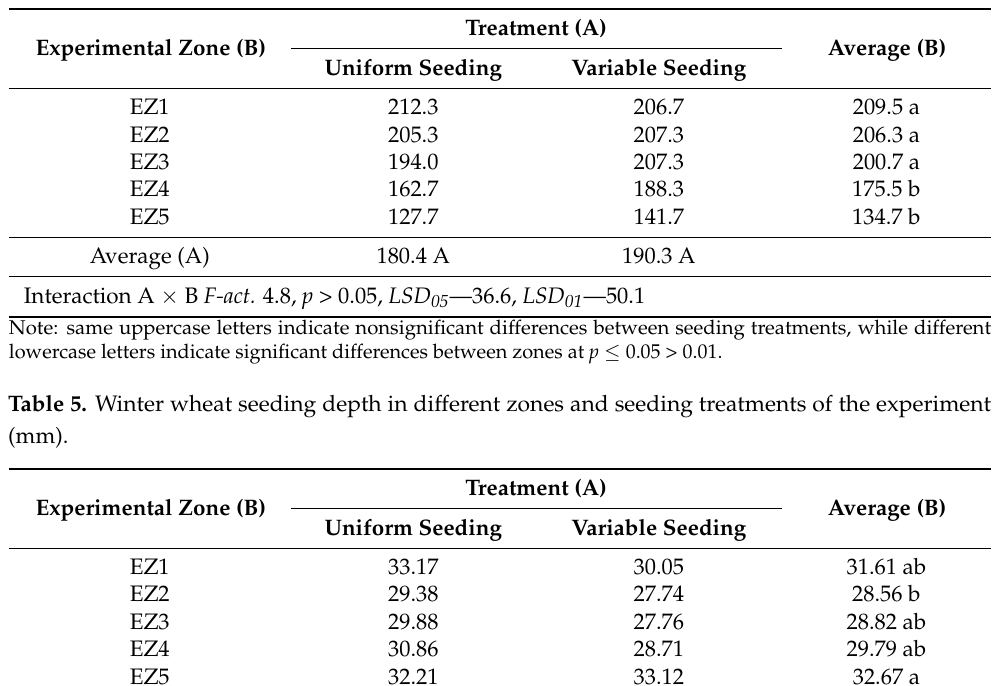
Table 4. Topsoil moisture content for different zones and seeding treatments of experiments and depths (g · kg − 1 ).